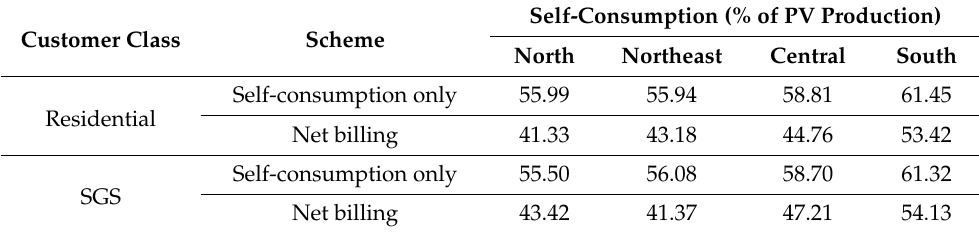
Table 3. Self-consumption level by region for residential and SGS customers.